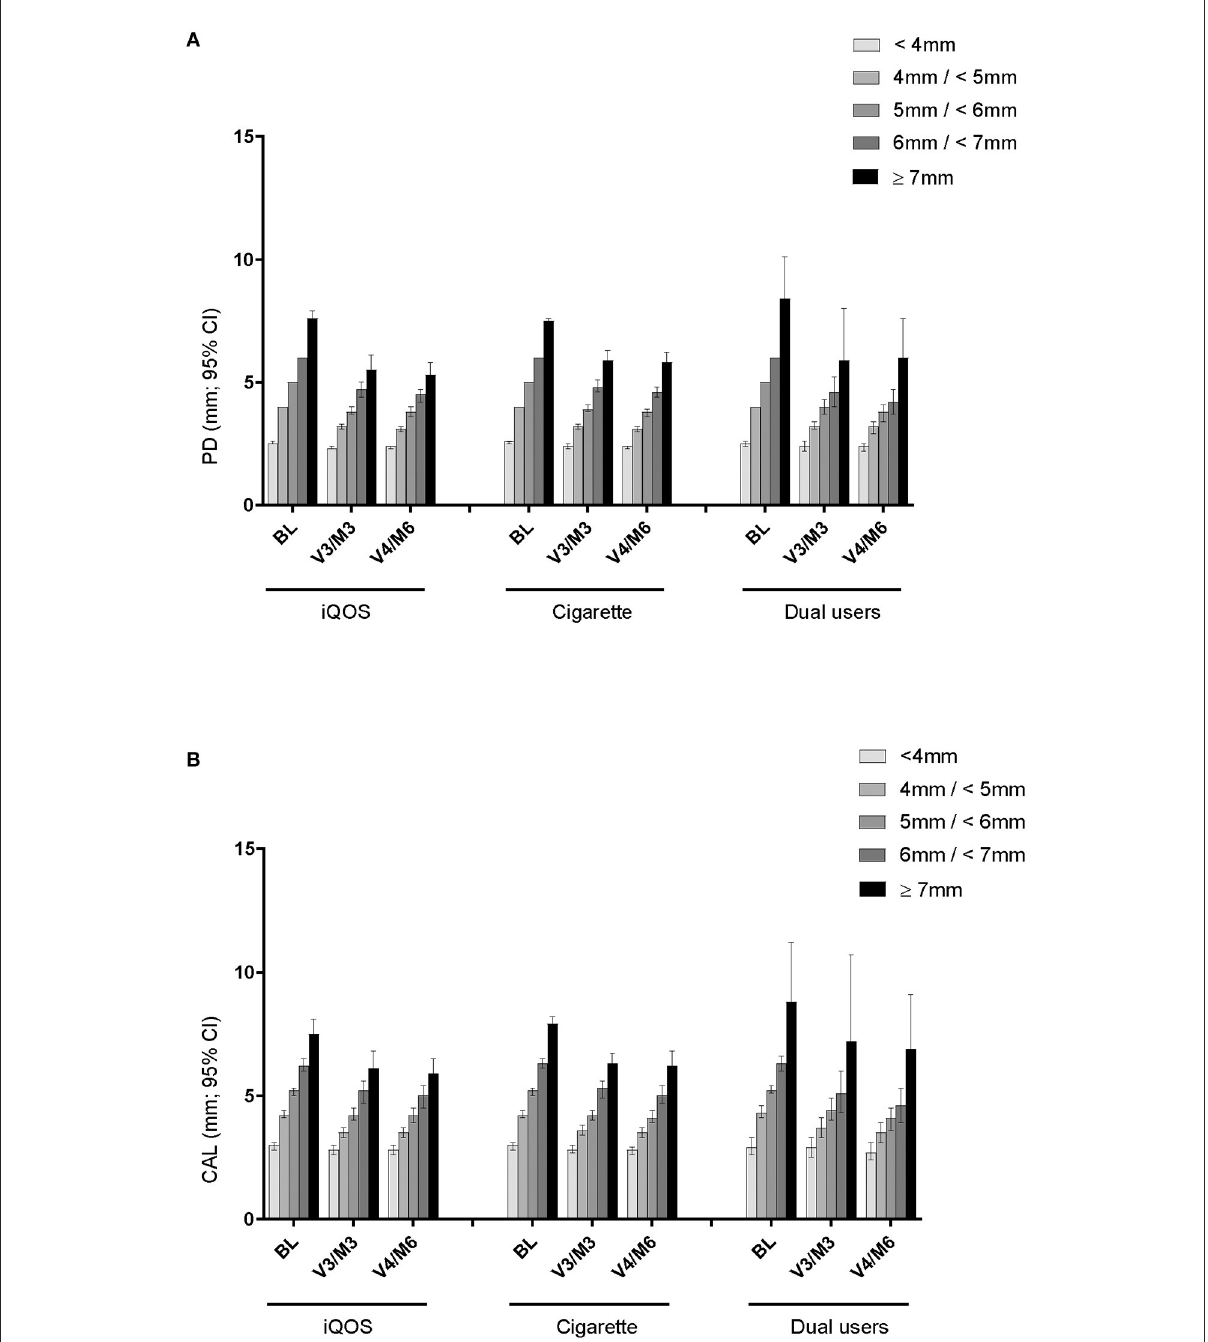
FIGURE3 Mean PD and CAL change in sites with different initial PD level. (A) PD of sites based on initial PD (mm) level. (B) CAL of sites based on initial PD (mm) level.